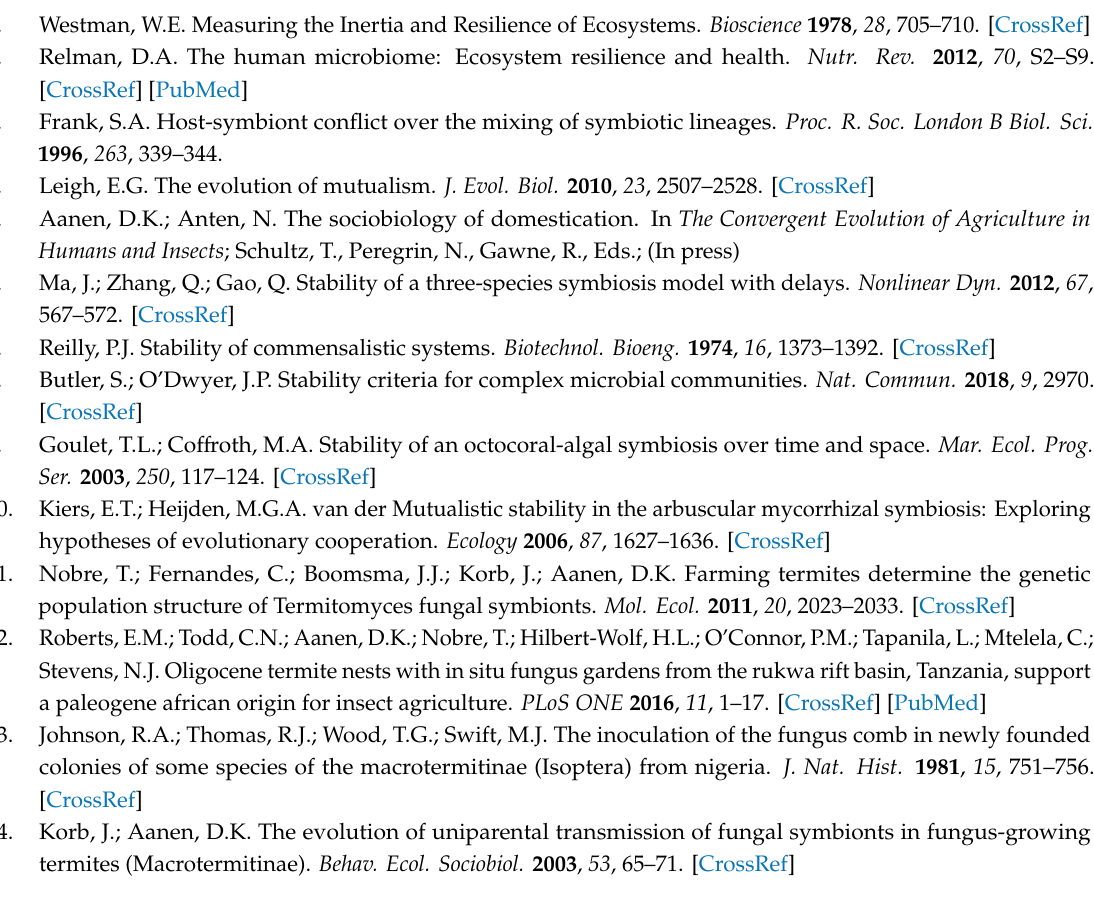
Table S1: Open questions and possible approaches to answer these questions. Grouped by